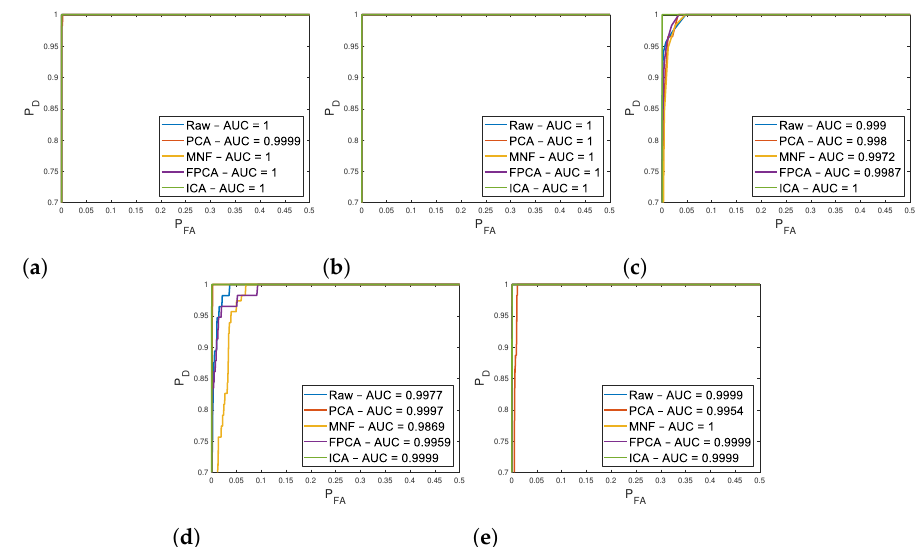
Figure 6. ROC Curves for each TD and spectral DR scheme pairing in combination with spatial DR. ( a ) ACE. ( b ) CEM. ( c ) SAM. ( d ) SID. ( e )